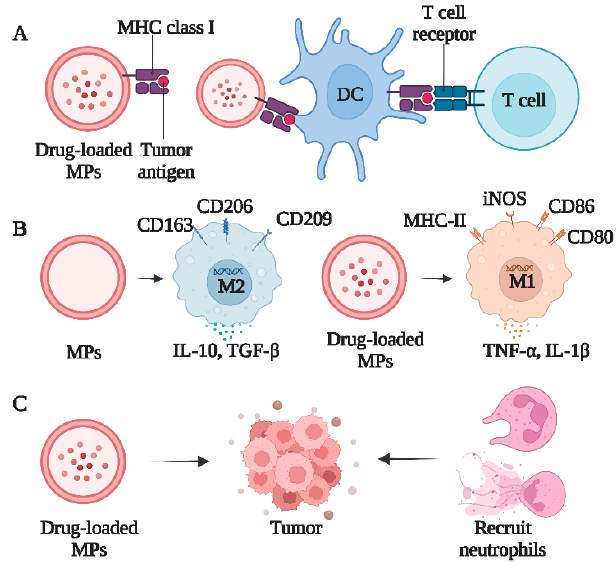
Figure 3. The dual significance of T-MPs in immune system modulation. ( A ) Drug-derived MP facilitate DC antigen presentation based on [58] (Cancer Immunology Research, 2018); ( B ) drug-derived MP promotes the M1 phenotype of macrophages based on [60,66] (OncoImmunology, 2016; Cellular & Molecular Immunology, 2019); ( C ) drug-derived MP recruits neutrophils based on [52] (Cancer Immunology Research, 2020).